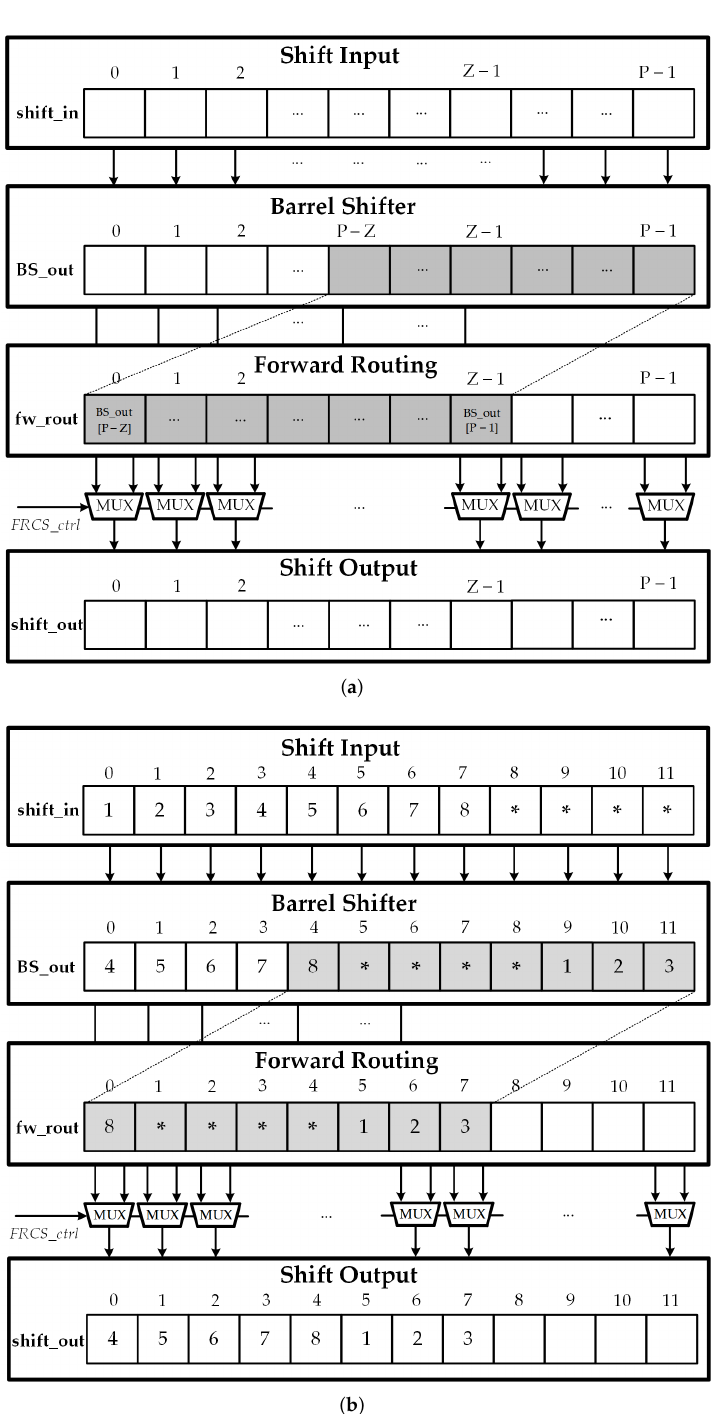
Figure 5. ( a ) FRCS network structure; ( b ) An example of FRCS network with Z = 8, P = 12 and c =